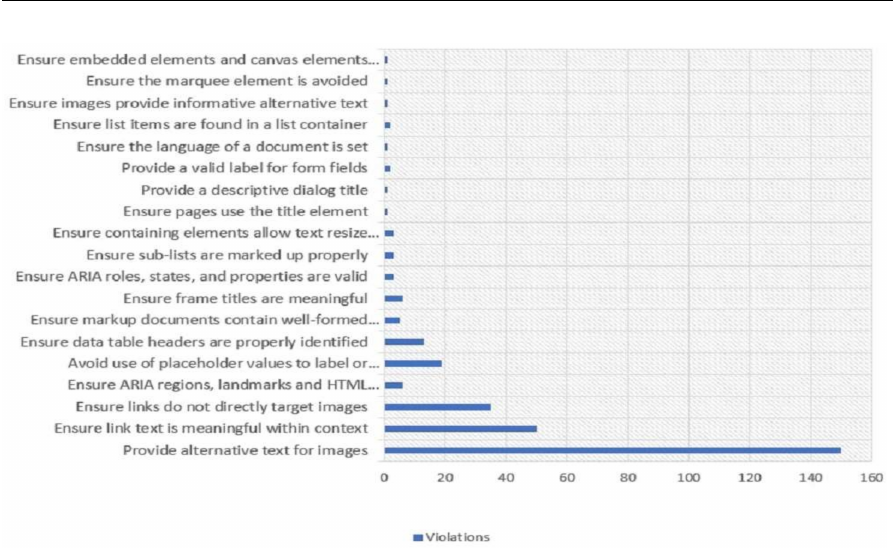
Figure 12. Violations identified by WEB accessibility